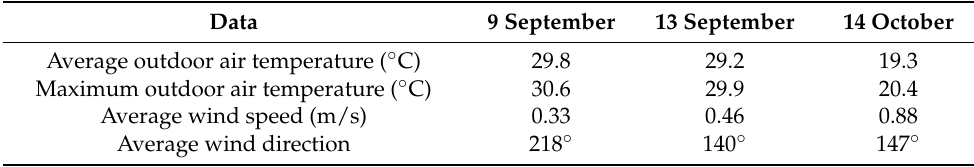
Figure 5. Air temperature variations in the cabin of two vehicles under different ambient conditions. Table 4. Ambient conditions on 9 September, 13 September, and 14